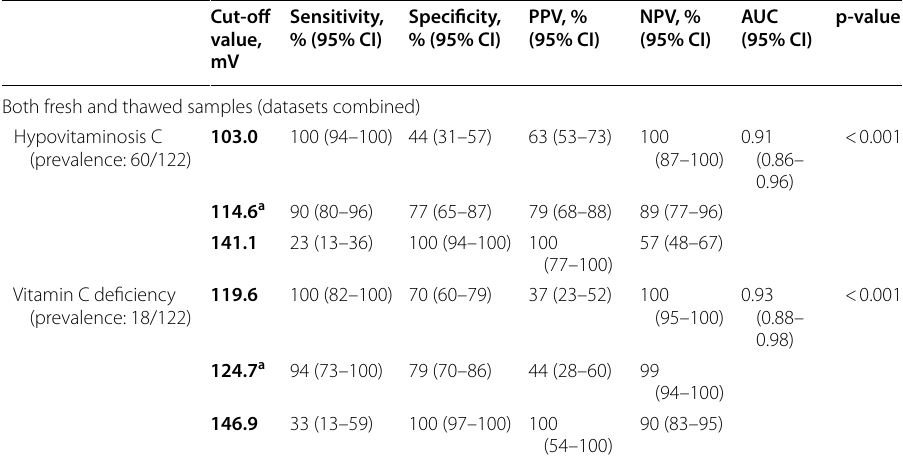
AUC area under the curve, CI confidence interval, NPV negative predictive value, PPV positive predictive value a Optimal cut‑off value, as chosen using Youden’s J Statistic